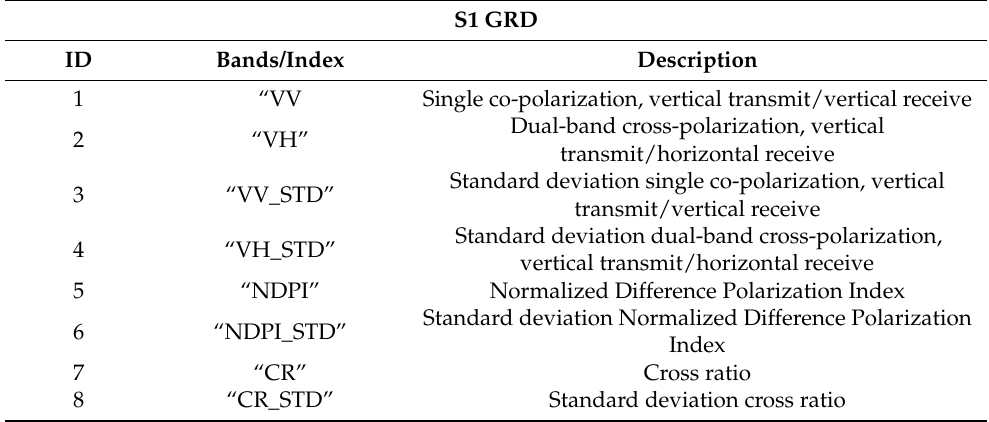
Table 5. SAR Sentinel-1 GRD bands in water mapping.